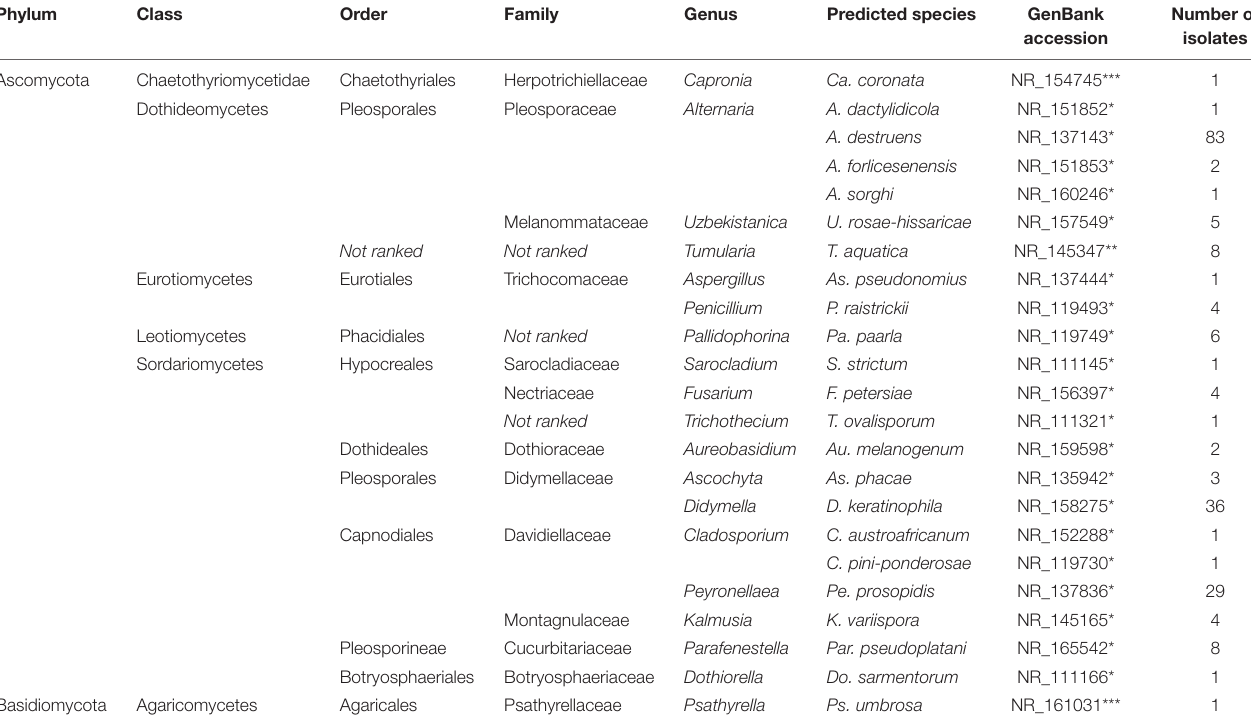
TABLE 1 | Identified fungal isolates from wild apple stems by internal transcribed spacer (ITS) sequence analysis and their taxonomic status.